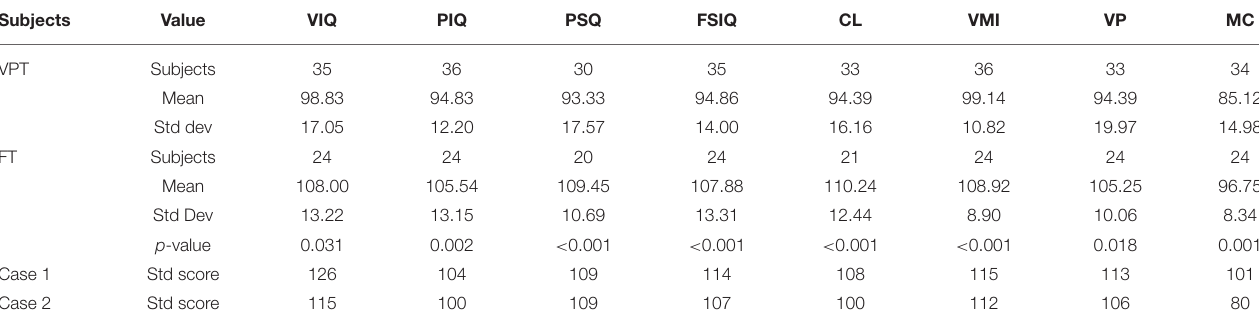
TABLE 2 | Developmental assessments at 4 years of age.